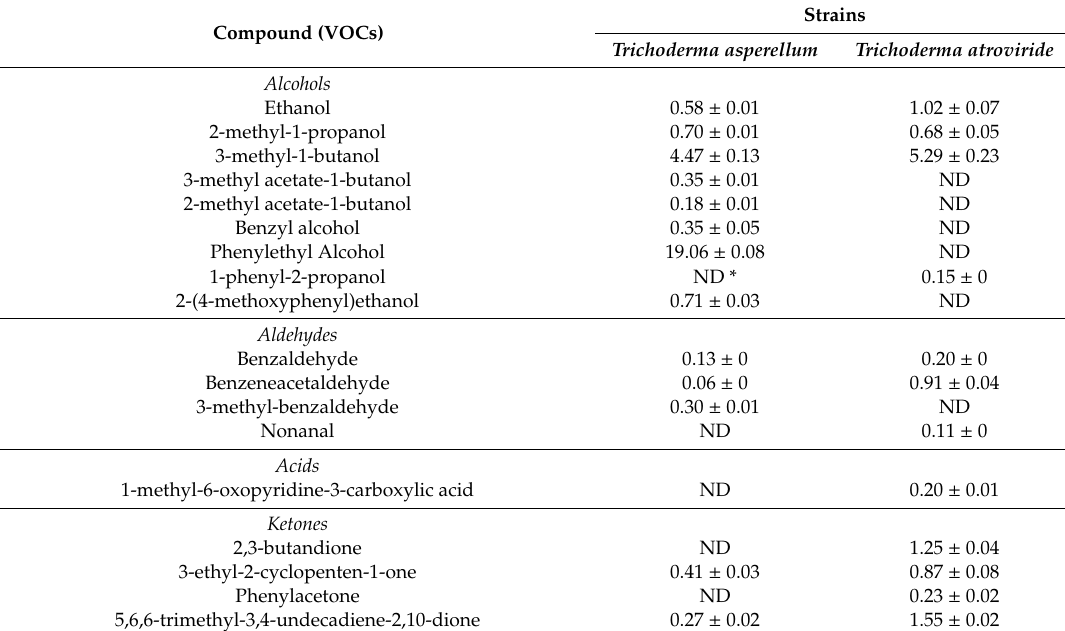
Table 4. Volatile organic compounds (VOCs) produced in the culture filtrate of Trichoderma asperellum IMI393899 and T . atroviride TS identified by GC-MS. Results are expressed as mean relative abundance percentages (as obtained by dividing the area of each peak by the total area of the chromatogram peaks) ± standard